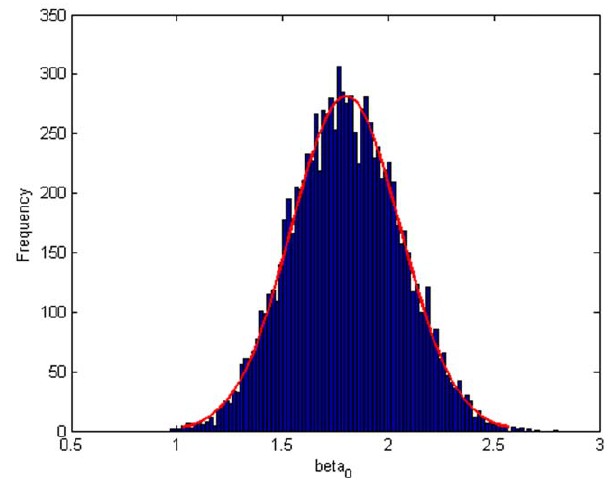
Figure 23. Normal Q-Q plot of residuals of ^ bb 1 of GLS when the variance function of the error term is s 2 ( x 1 , x 2 ) ~ exp ( { ( x 2